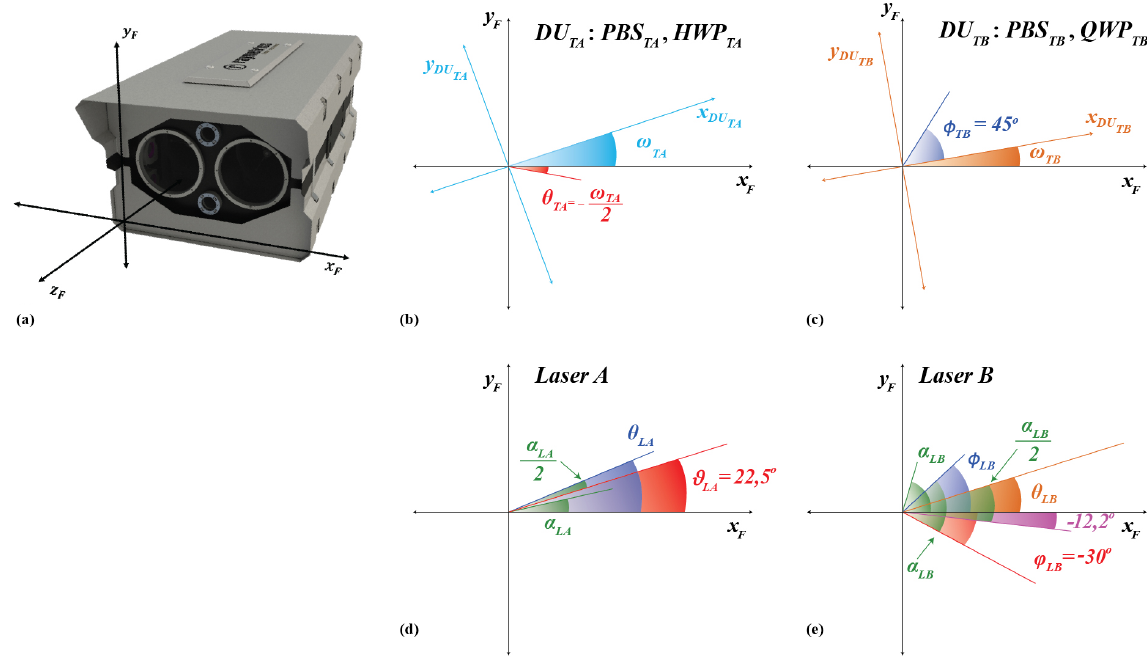
Figure 8. (a) The “frame coordinate system” (black) is the reference coordinate system with the x F axis parallel to the horizon. (b) The “DU TA coordinate system” (light blue) is the coordinate system of the detection unit after telescope A, which is rotated with respect to the frame coordinate system by an angle ω TA . The effect of this rotation on the signals is corrected using HWP TA , placed at θ TA = − ω TA 2 (red) with respect to the x F axis. (c) The “DU TB coordinate system” (orange) is the coordinate system of the detection unit after telescope B, which is rotated with respect to the frame coordinate system by an angle ω TB . The rotation does not affect the measured signals. The QWP TB before PBS TB is placed at φ TB = 45 ◦ with respect to the x DU axis. (d) The light emitted directly from laser A is linearly polarized TB , we produce the with unknown angle of polarization α LA . As shown in Eq. (11), using the HWP LA with fast-axis angle θ LA = 22 . 5 ◦ + α LA 2 light emitted from the emission unit of laser A with angle of polarization 2 ϑ LA = 45 ◦ . (e) The light emitted directly from laser B is linearly polarized with unknown angle of polarization α LB . As shown in Eq. (12), using the QWP LB with fast-axis angle φ LB = α LB − 30 ◦ and the − 12 . 2 ◦ , we produce the elliptically polarized light emitted from the emission unit of laser B with HWP LB with fast-axis angle θ LB = α LB 2 angle of polarization 5.6 ◦ and degree of linear polarization